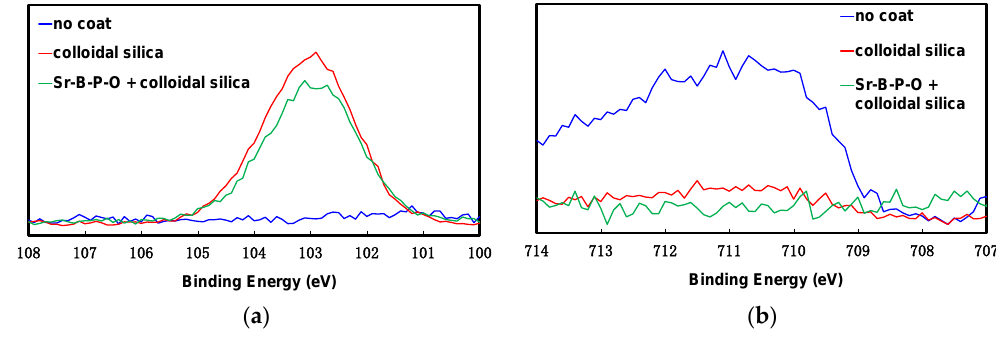
Figure 3. X-ray photoelectron spectroscopy (XPS) ( a ) Si2p; and ( b ) Fe2p3/2 core level spectra of uncoated iron powder particles and iron power particles coated five times with colloidal silica with and without Sr-B-P-O insulating layers.